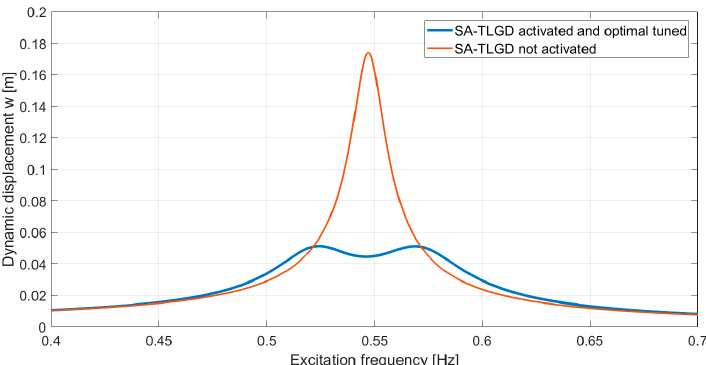
Figure 5. Frequency response functions (FRF) of the SDOF-wind turbine with and without activated optimally tuned SA-TLGD (steady state response of the horizontal tower head displacement w ).